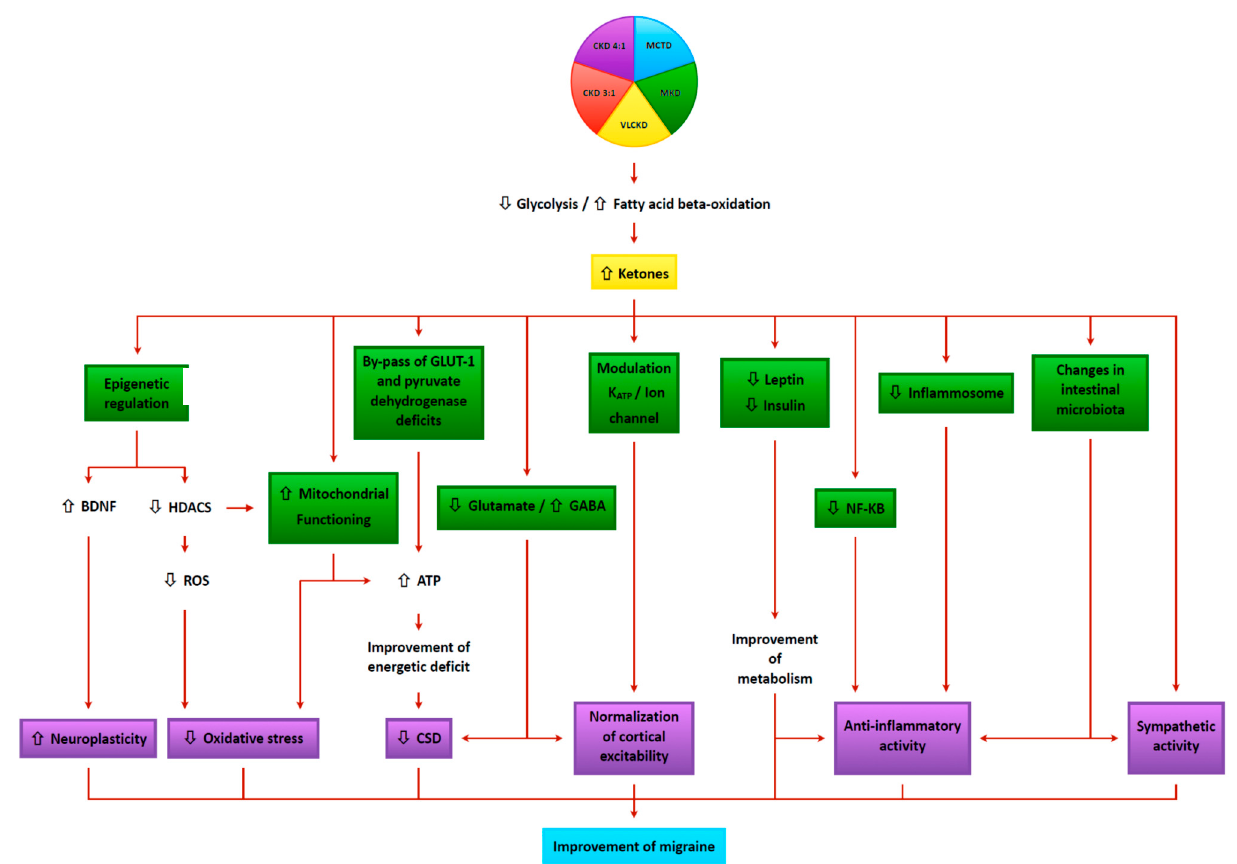
Figure 4. Potential mechanisms of action of the ketogenic diets in the management of headache. ATP = Adenosine triphosphate; BDNF = Brain Derived Neurotrophic Factor; CKD 3:1 = Classic ketogenic diet with ketogenic ratio 3:1; CKD 4:1 = Classic ketogenic diet with ketogenic ratio 4: 1; CSD = Cortical Spreading Depression; GABA = Gamma-aminobutyric acid; GLUT-1 = Glucose transporter protein 1; HDAC = Histone deacetylase; K ATP = adenosine triphosphate-sensitive potassium channels; LGIT = Low glycemic index diet; MCTD = Medium chain triglyceride diet; MKD = Modified ketogenic diet; ROS = Reactive oxygen species; VLCKD = Very low-calorie ketogenic diet.